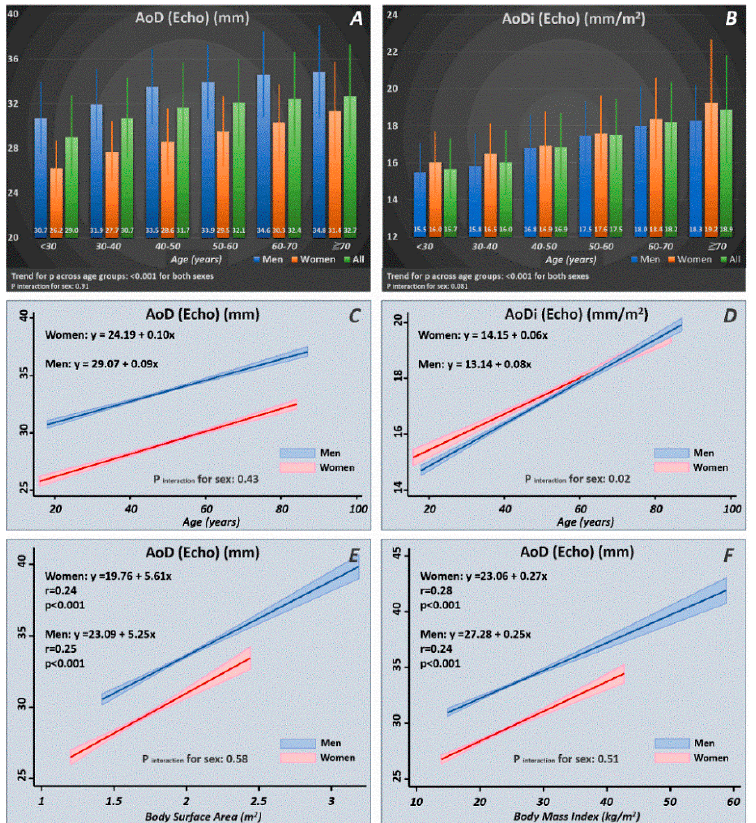
Figure 2. Normal reference ranges of AoD / AoDi by age and sex strata ( A , B ) drawn from our healthy participants ( n = 3646). Linear relationships of AoD / AoDi with increasing age ( C , D ) and larger body size in terms of body surface area (BSA) and body mass index (BMI) ( E , F ) in men and women. AoD: aortic root diameter; AoDi: indexed aortic root diameter; Echo: echocardiography.